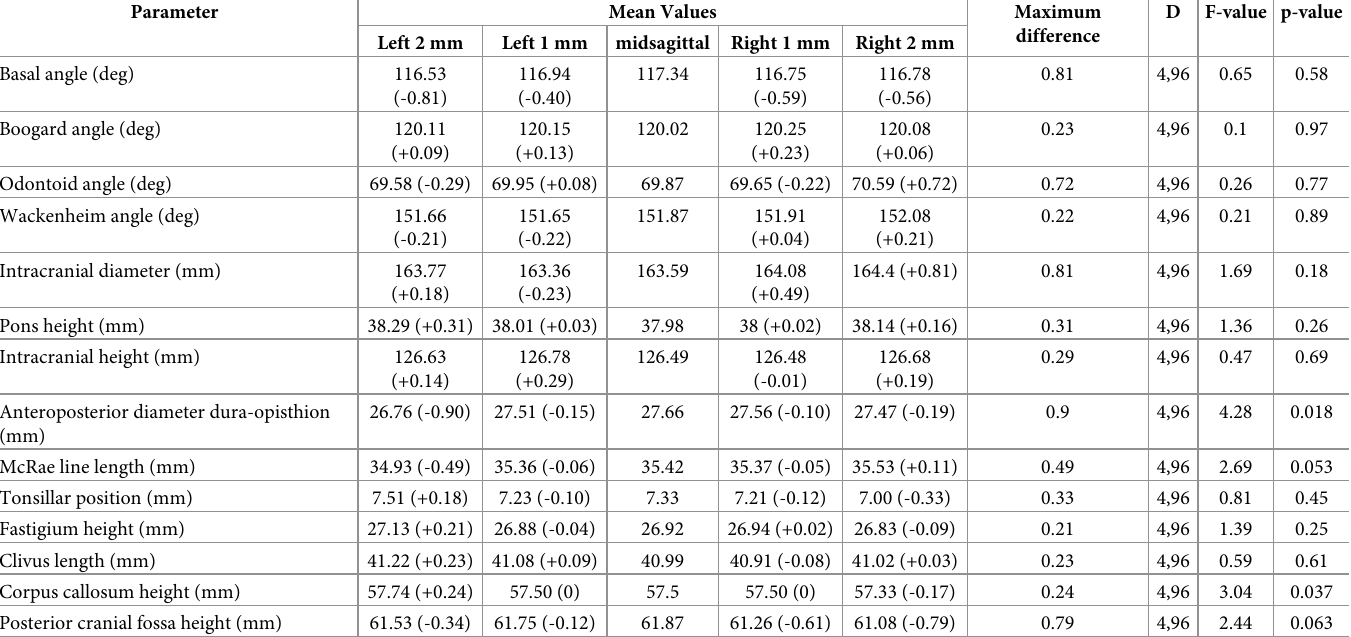
Table 2. ANOVA results for group differences from the midsagittal plane to parasagittal planes 1 and 2 mm lateral (n = 25). � Note critical value is p < 0.0083 after Bonferroni correction. Differences from midsagittal measurements (MGPE) are given in parentheses. D = degrees of freedom.